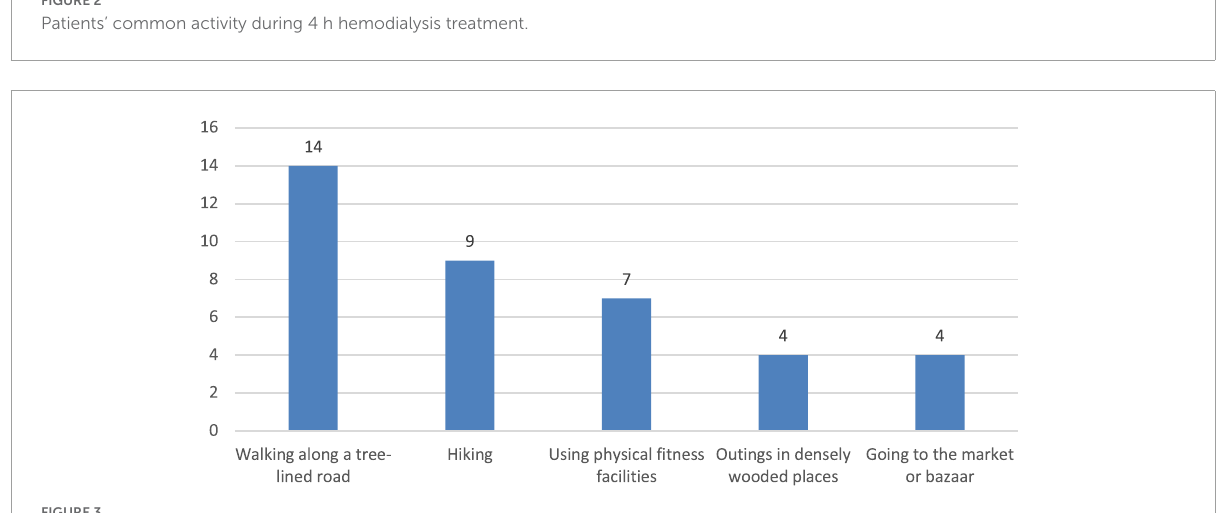
FIGURE3 Preferred outdoor recreational activity, as found in interviews with hemodialysis patients.